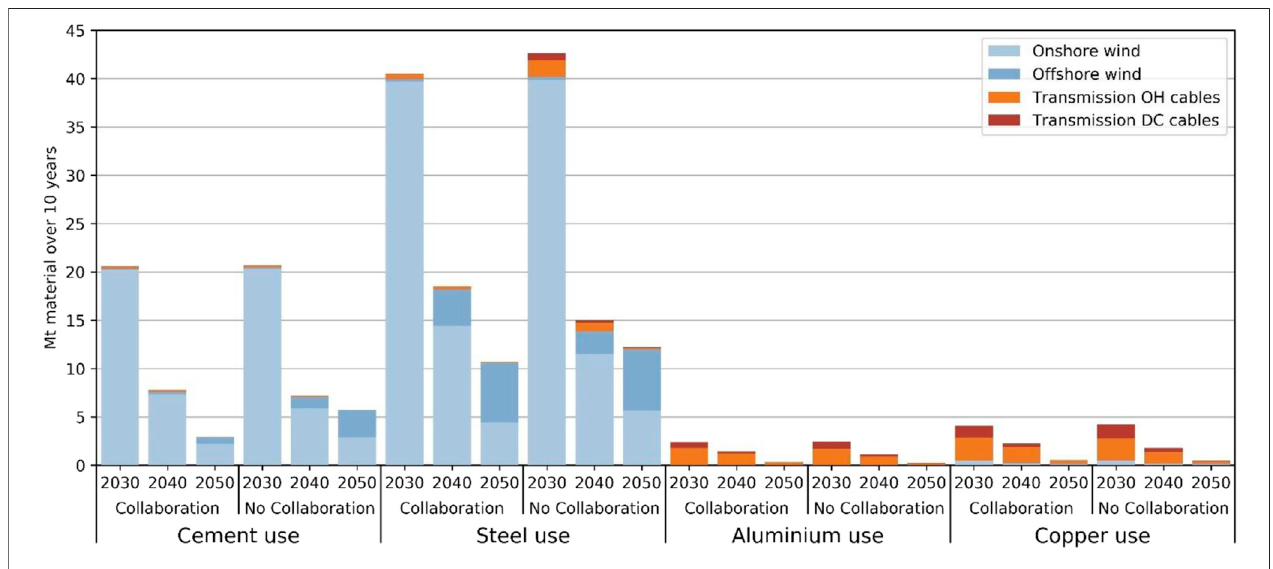
FIGURE 4 | Material usage of base materials in the analysed